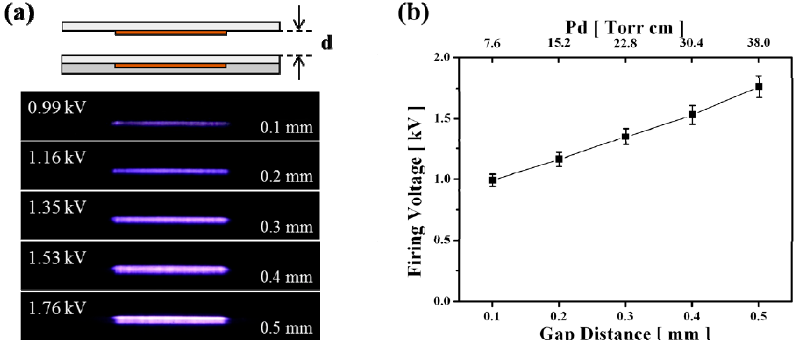
Figure 3. Cross-sectional pictures of the spatial discharge at the ignition voltage ( V f ) according to the gap distance ( d ) with the dielectric barrier discharge (DBD) structure shown in Figure 1a in ( a ) and the Paschen curve with the firing voltage ( V f ) versus the d in ( b ).